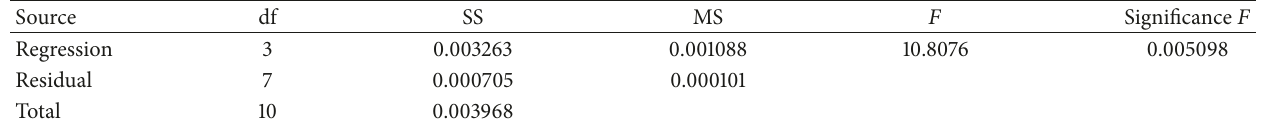
Table 9: Analysis of variance (ANOVA).